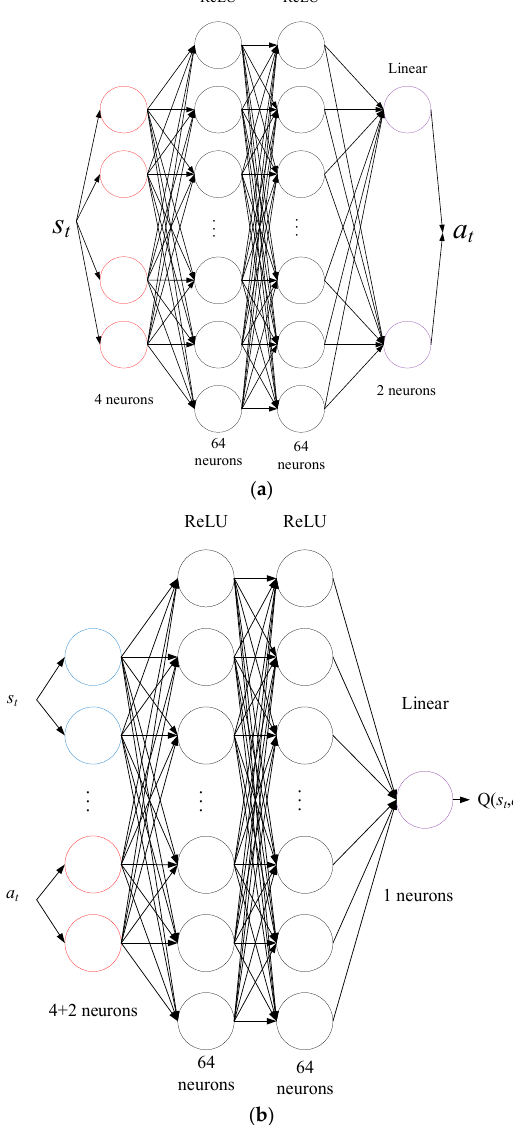
Figure 9. Architecture of the network. ( a ) The strategy network. ( b ) The evaluation network. The decay rate of the DDPG algorithm γ is 0.9. The learning rate of the strategy network is 0.0001. The learning rate of the evaluation network is 0.001. A total of 64 samples are selected for each learning process. The size of the experience pool is 10,000. The